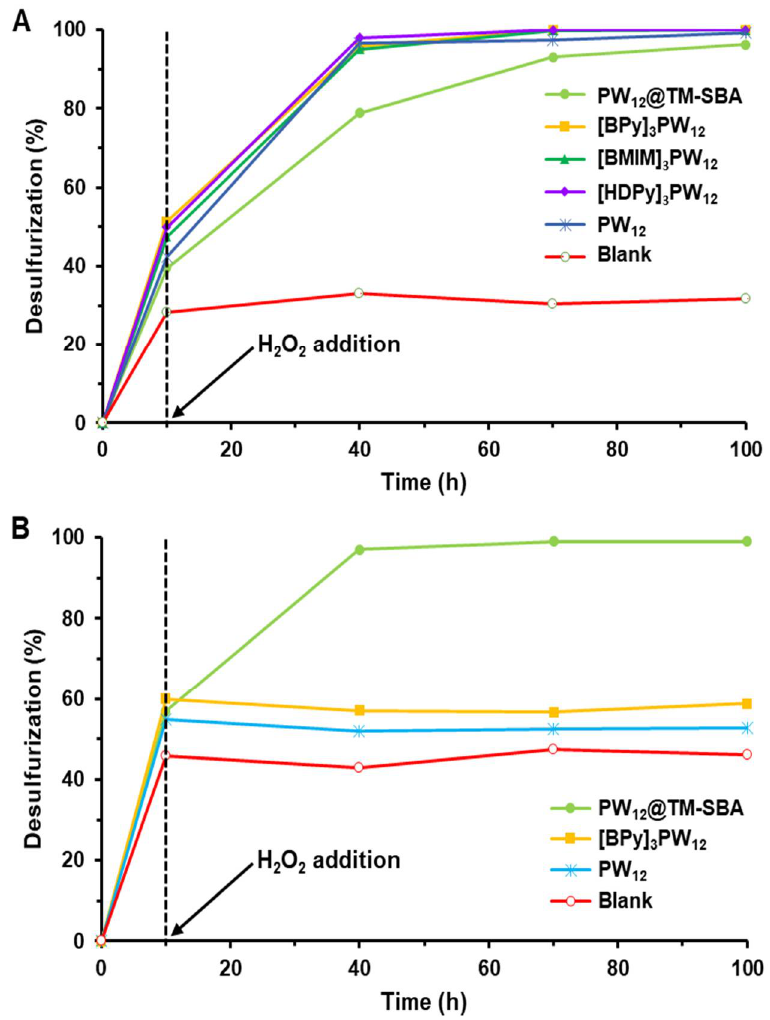
Figure 4. Kinetic desulfurization profiles of the extractive and catalytic oxidative desulfurization (ECODS) process catalyzed by PW 12 , IL–PW 12 compounds, composite material and blank experiments (without catalyst) using ( A ) [BMIM]PF 6 and ( B ) MeCN as extraction solvents at 70 °C.